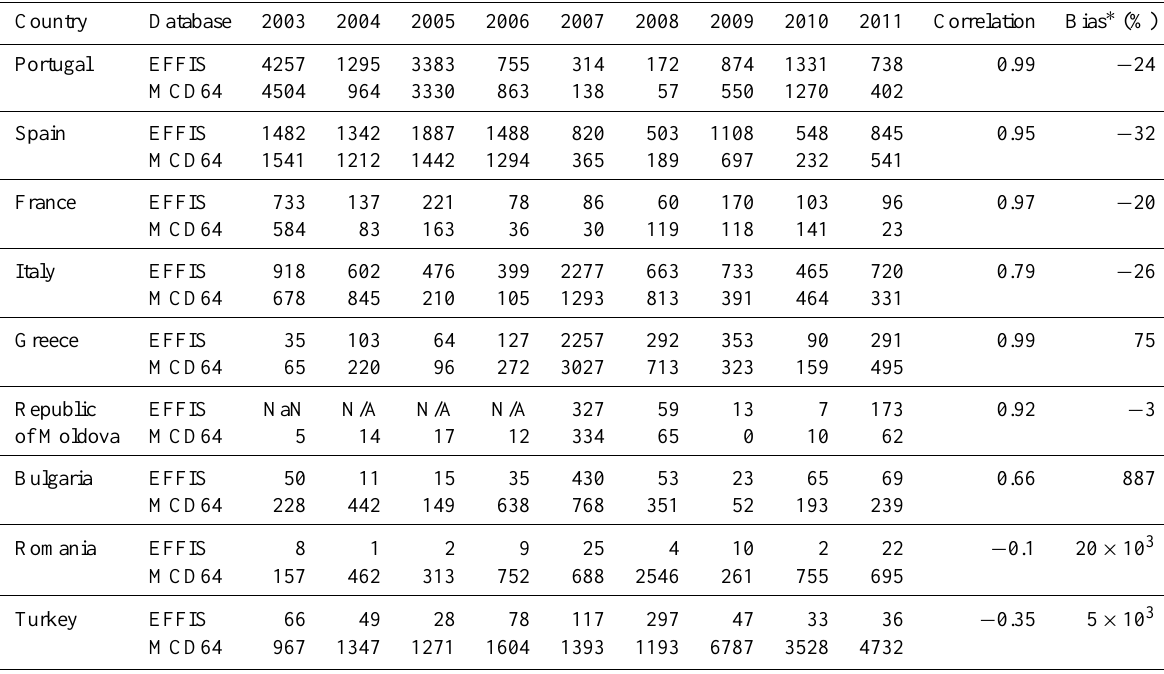
Table 2. Comparison of total yearly burned area (km 2 ) by country from the EFFIS/JRC reports and this study (derived from MODIS